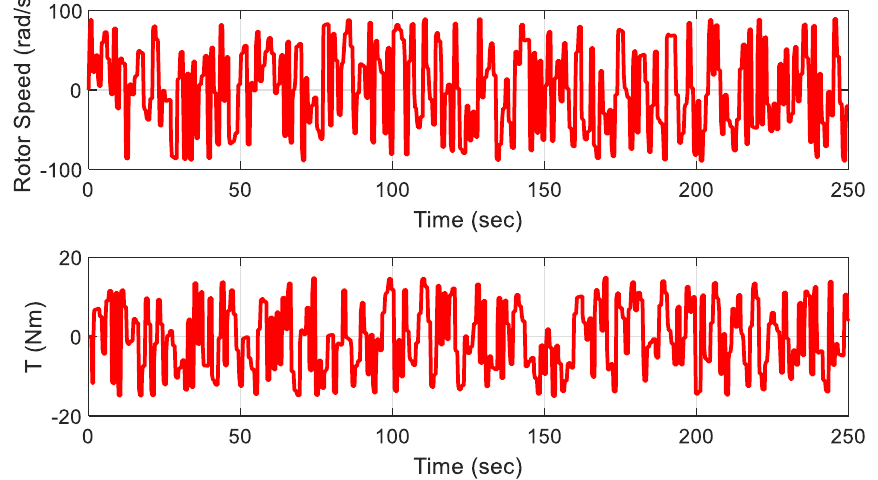
Figure 2. Applied reference speed and load torque while collecting the training data.